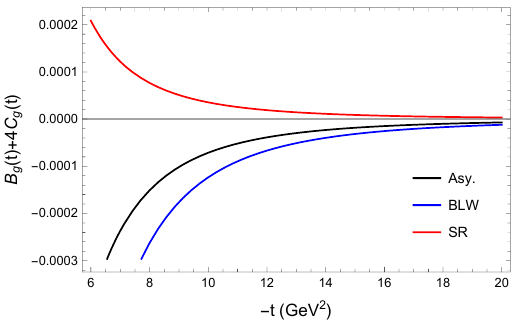
Figure 5. B q ( t ) + 4 C g ( t ) with different estimates or models of nucleon DAs: QCD sum rule(SR) [81, 98], Braun-Lenz-Wittman(BLW) model [98], the asymptotic(Asy.)